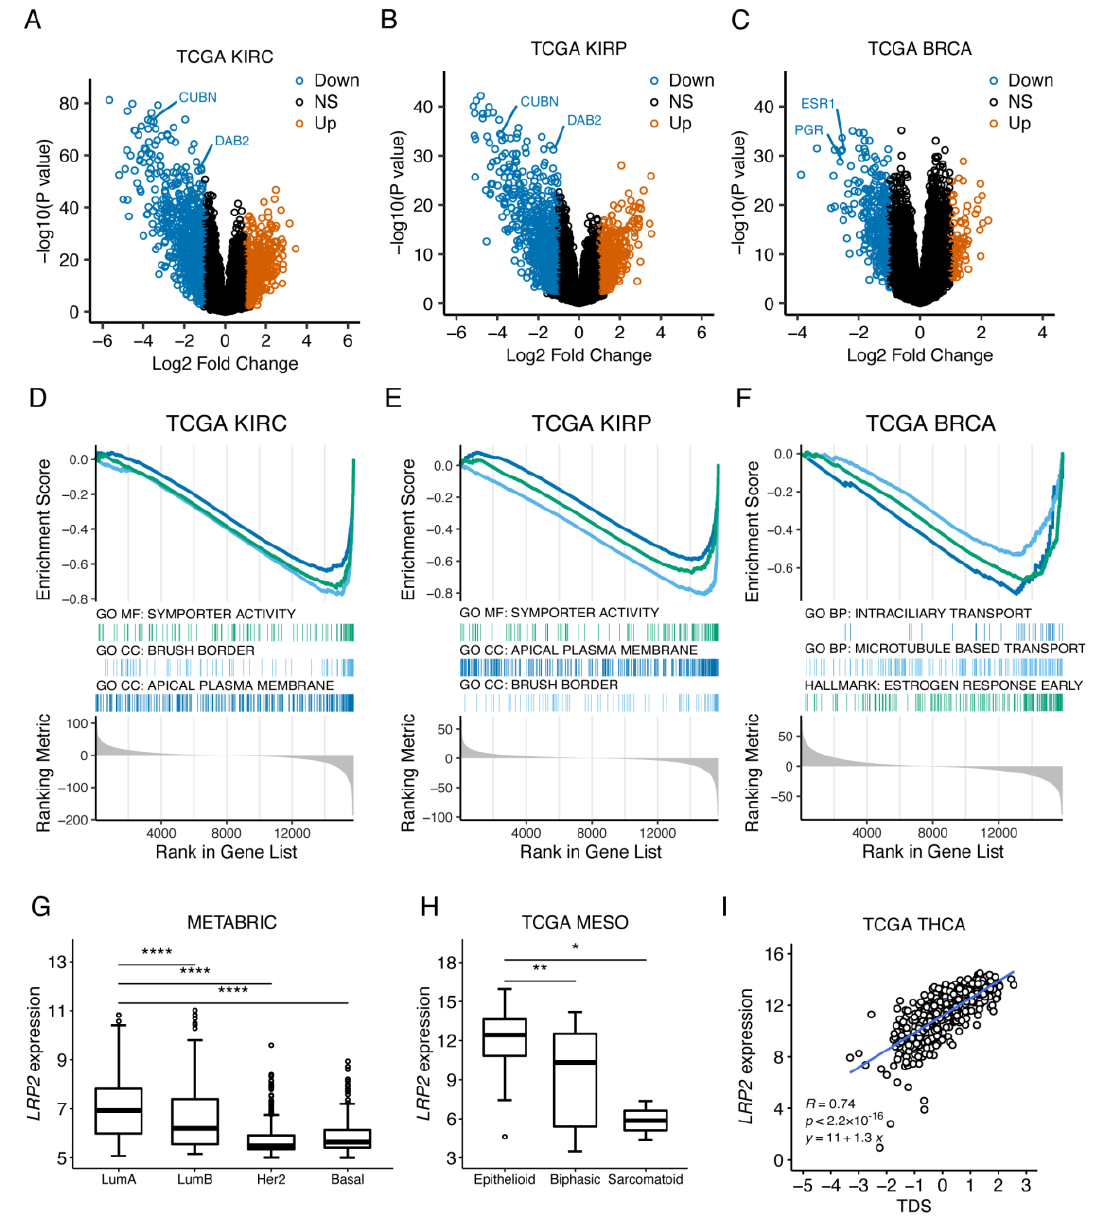
Figure 8. LRP2 silencing is associated with tumor dedifferentiation. ( A – C ) Volcano plot of differential gene-expression analysis of LRP2 low versus LRP2 high tumors (lower quartile cutoff) in KIRC (panel A), KIRP (panel B), and BRCA (panel C). Genes downregulated in LRP2 low tumors (FDR < 0.01 and log2 fold change < − 1) are shown in blue. Genes upregulated in LRP2 low tumors (FDR < 0.01 and log2 fold change > 1) are shown in orange. Non-significant genes (FDR > 0.01) are shown in black. ( D – F ) Enrichment plots from gene set enrichment analysis showing selected top pathways downregulated in LRP2 low tumors in KIRC (panel D), KIRP (panel E), and BRCA (panel F). ( G ) Boxplot of LRP2 expression across PAM50 molecular subtypes in breast cancer cohort METABRIC. ( H ) Boxplot of LRP2 expression (RSEM norm_count log2 transformed with offset of 1) across histological subtypes in TCGA MESO. Boxplot lines represent lower quartile, median, and upper quartile. Whiskers represent 1.5 times above or below interquartile range. Points reflect outliers. ( I ) Scatter plot of correlation between LRP2 expression (RSEM norm_count log2 transformed with offset of 1) and 16-gene tumor differentiation score in TCGA THCA. Pearson’s R and corresponding p values are shown together with the linear regression line and equation. Wilcox rank-sum test: * p ≤ 0.05, ** p ≤ 0.01, **** p ≤ 0.0001. TDS: tumor differentiation score.